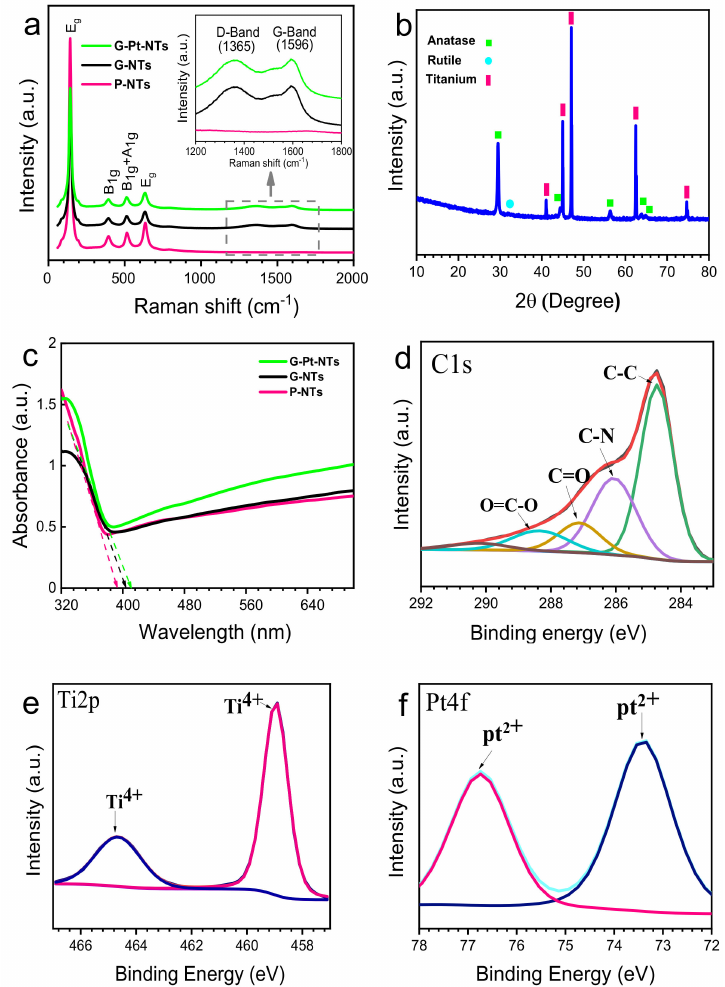
Figure 3. ( a ) Raman spectra of P-NTs, G-NTs and G-Pt-NTs. The inset shows the magnified Raman spectra. ( b ) XRD pattern of TiO 2 nanotubes using cobalt X-ray source annealed at 450 ◦ C in air. ( c ) UV-vis di ff use reflectance spectra (DRS) of P-NTs, G-NTs, and G-Pt-NTs, and ( d – f ) high-resolution XPS spectra of C1s ( d ), Ti2p ( e ), and Pt4f ( f ) of G-Pt-NTs